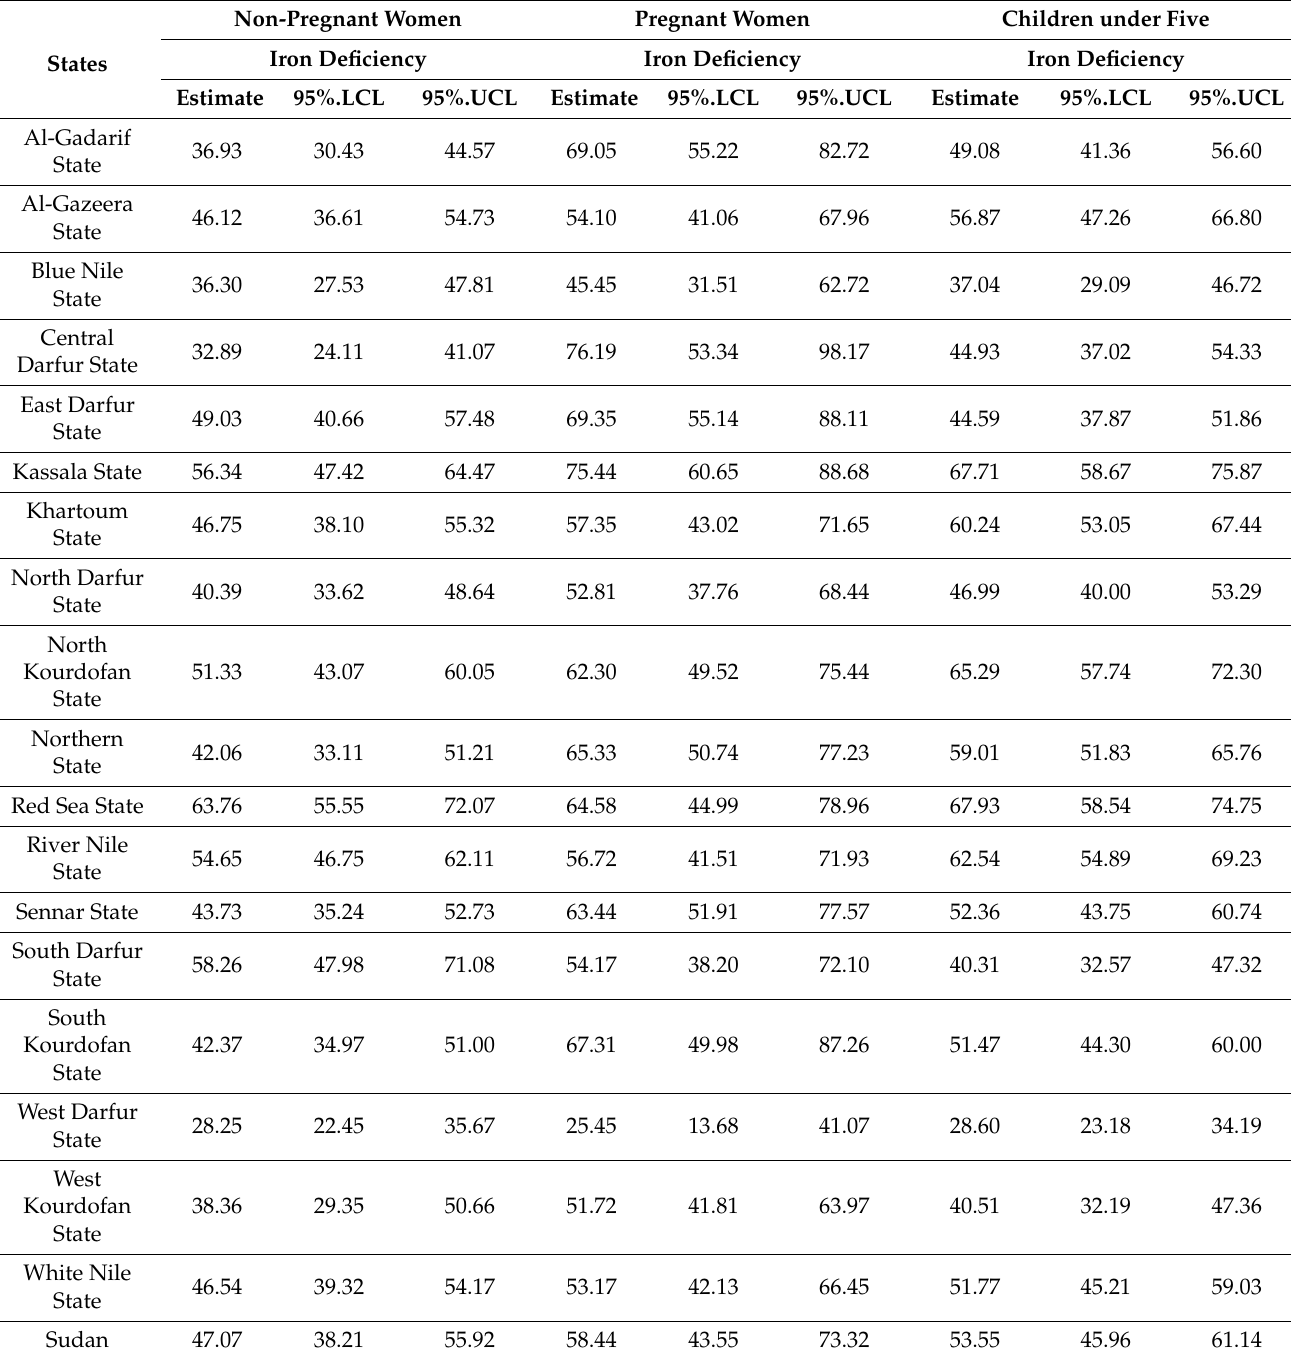
Table 6. The estimation of median-adjusted serum ferritin (ng/mL), iron deficiency among reproductive-age women (15-49 years of age), and these women’s